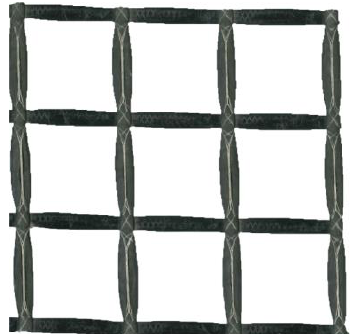
Figure 1. Carbon textile impregnated with epoxy resin.